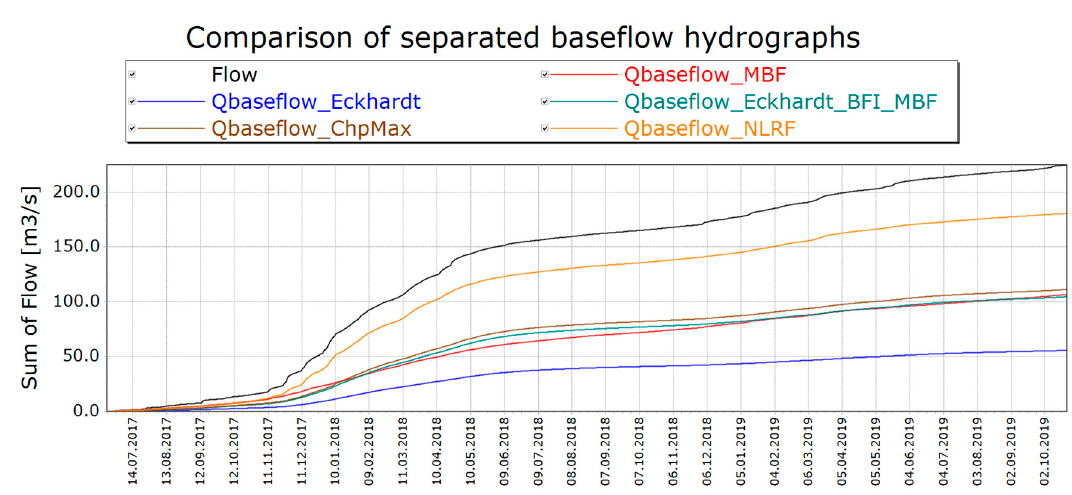
Figure 14. Cumulative sum of flow as well as estimated baseflow at station M.